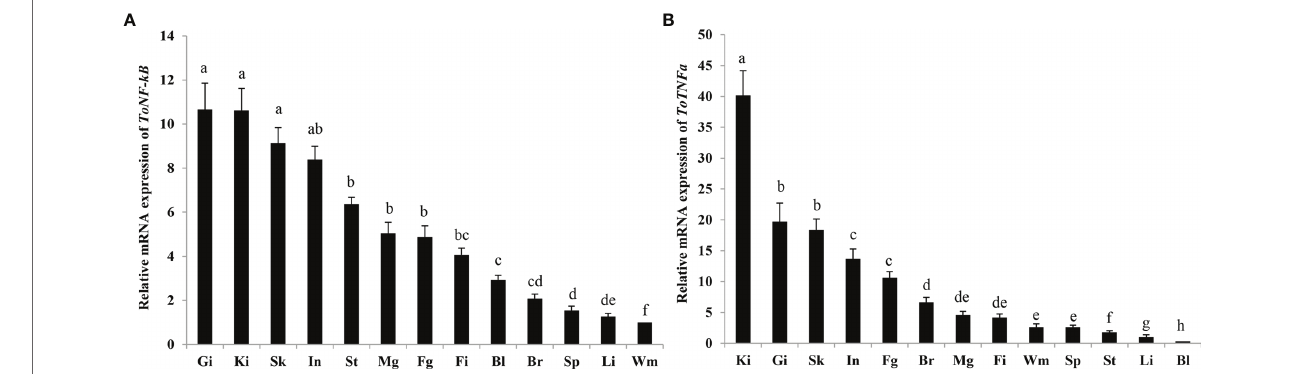
FIGURE 4 | Expression patterns of ToNF - κ B (A) and ToTNF α (B) gene transcripts in various tissues. The 12 tissues are skin (Sk), brain (Br), blood (Bl), gill (Gi), fin (Fi), head-kidney (Ki), small intestine (In), stomach (St), spleen (Sp), liver (Li), white muscle (Wm), female gonad (Fg), and male gonad (Mg). Different letters indicate significant differences ( p < 0.05).